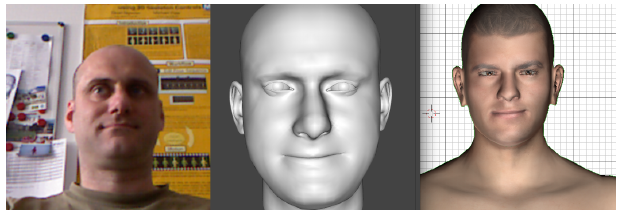
Figure 6. From left to right, screenshots of: the live Kinect color camera, the preview in FaceShift, the rendered